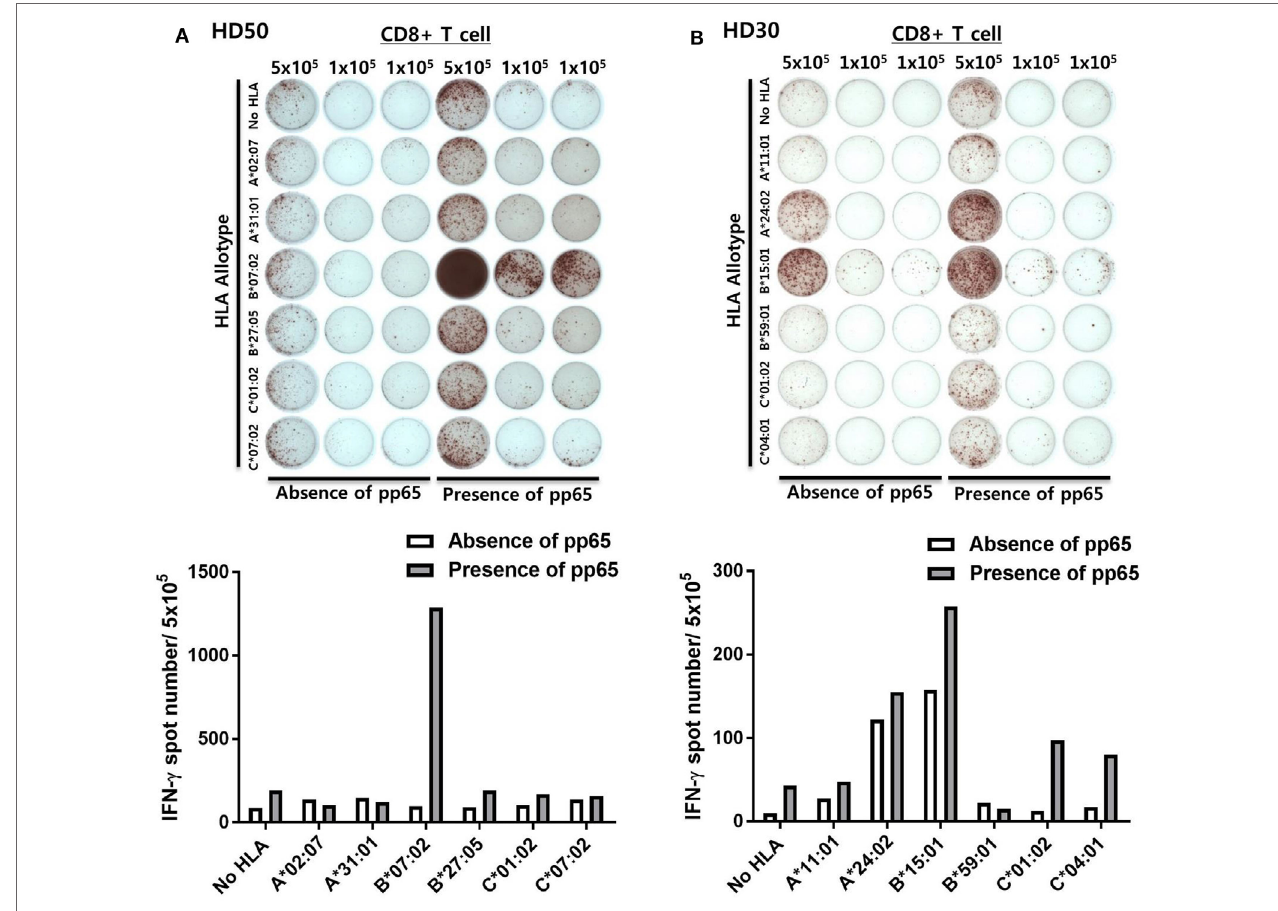
FigUre 2 | Simultaneous measurement of cytomegalovirus (CMV) pp65 antigen­specific CD8 + T cell responses presented by each of the six human leukocyte antigen (HLA) class I allotypes in an individual by enzyme­linked immunospot (ELISPOT). (a) Representative ELISPOT assay results. The frequency of CD8 + T cells secreting interferon­ γ (IFN­ γ ) was measured using aAPCs (aAPC­HLA) and aAPC­pp65 (aAPC­pp65­HLA) transfected with individual HLA class I allotypes (HLA­A*02:07, ­A*31:01, ­B*07:02, ­B*27:05, ­C*01:02, and ­C*07:02) of HD50. CD8 + T cells were seeded at 5 × 10 5 per well in one well and at 1 × 10 5 per well in two wells for each allotype and background groups. The background for aAPCs and aAPC­pp65 was defined as the frequency of IFN­ γ secreting CD8 + T cells induced by each aAPC without HLA gene transfer. The frequency of IFN­ γ secretion in CD8 + T cells, excluding background values, is presented. Finally, the frequency of pp65­specific T cells was determined as [(aAPC­pp65­HLA) − (aAPC­pp65)] − [(aAPC­HLA) − (aAPC)]. (B) Representative example showing non­specific responses in aAPCs expressing specific HLA allotypes (HLA­A*24:02 and ­B*15:01) in